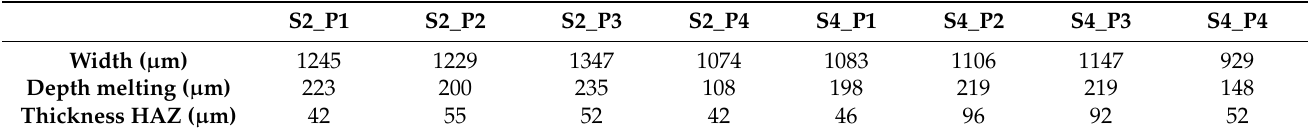
Table 3. Bead measures in different zones (0.3 mm/s speed).